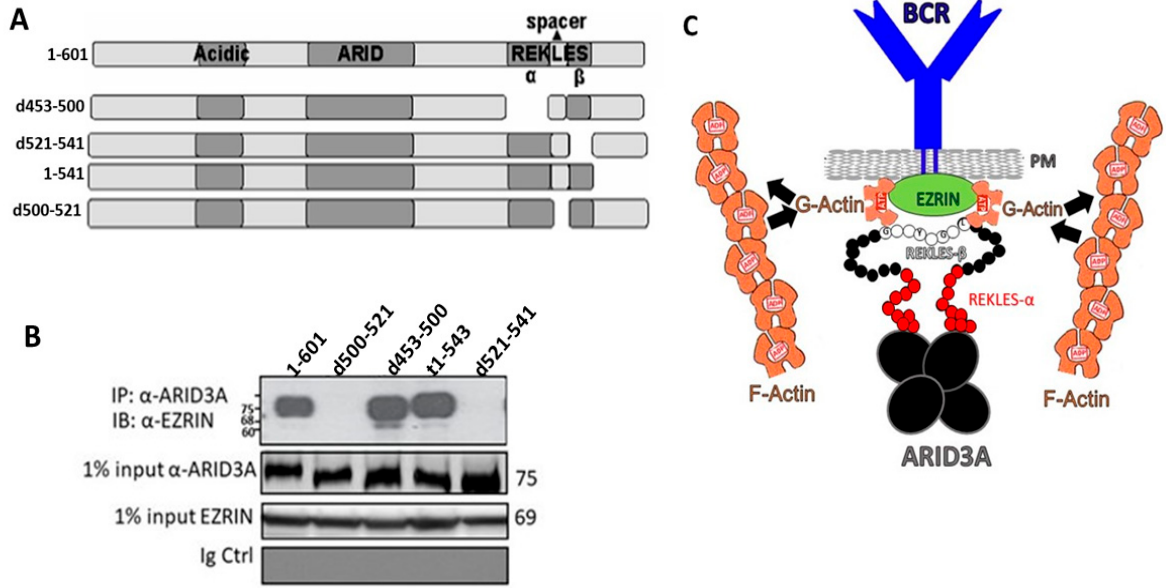
Figure 4. REKLES- β deletions abrogate ARID3A–EZRIN interaction. ( A ) Diagram of ARID3A REKLES deletion (d) mutants. Deletions are indicated by gaps. ( B ) EZRIN–ARID3A interaction was abrogated only by deletion (d453–500 and d521–541) of the REKLES- β domain. Full-length ARID3A and its deletion mutants of ( A ) were transfected into COS7 cells and lysates were immunoprecipitated with anti-ARID3A prior to resolution on SDS-PAGE followed by anti-EZRIN Western blotting (upper panel); normalization of equivalent inputs (middle panels); anti-EZRIN background control (lower panel). ( C ) ARID3A is tethered to G-actin via interaction of its REKLES- β domain with EZRIN. Cartoon summarizing and extending the findings of this report. We speculate that when the ARID3A tetramer (large black spheres) interacts with EZRIN (green sphere) via a patch of conserved REKLES- β residues (small black spheres with single amino acid codes in white) and proximal spacer residues (small red spheres), EZRIN is discharged from lipid rafts in order to release lipid- rafts-associated ATP-G-actin (brown semicircles), possibly for polymerization to ADP-F-actin (brown chains). Transfected lysates were immunoprecipitated with a polyclonal anti-ARID3A Ab which was previously shown to pull down each of the input mutants [34–36]. After ad- justing for equivalent levels of immunoprecipitated ARID3A inputs (Figure 4B, middle panel), WT and mutant lysates were fractionated on SDS-PAGE and then Western blotted